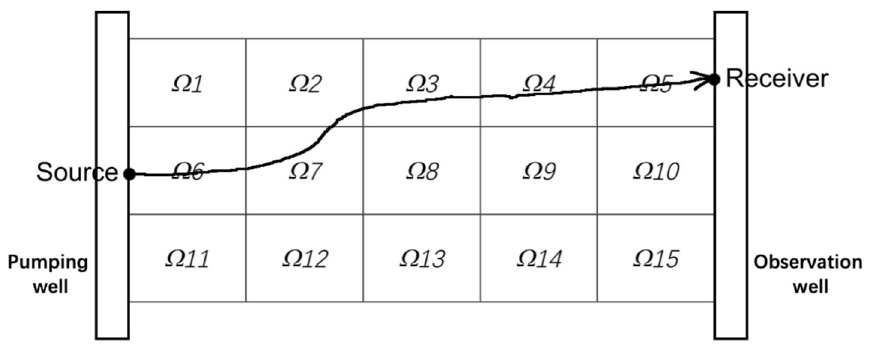
Figure 1. An example of investigation area Ω . Black line illustrates the travel path of a signal through the investigation area.